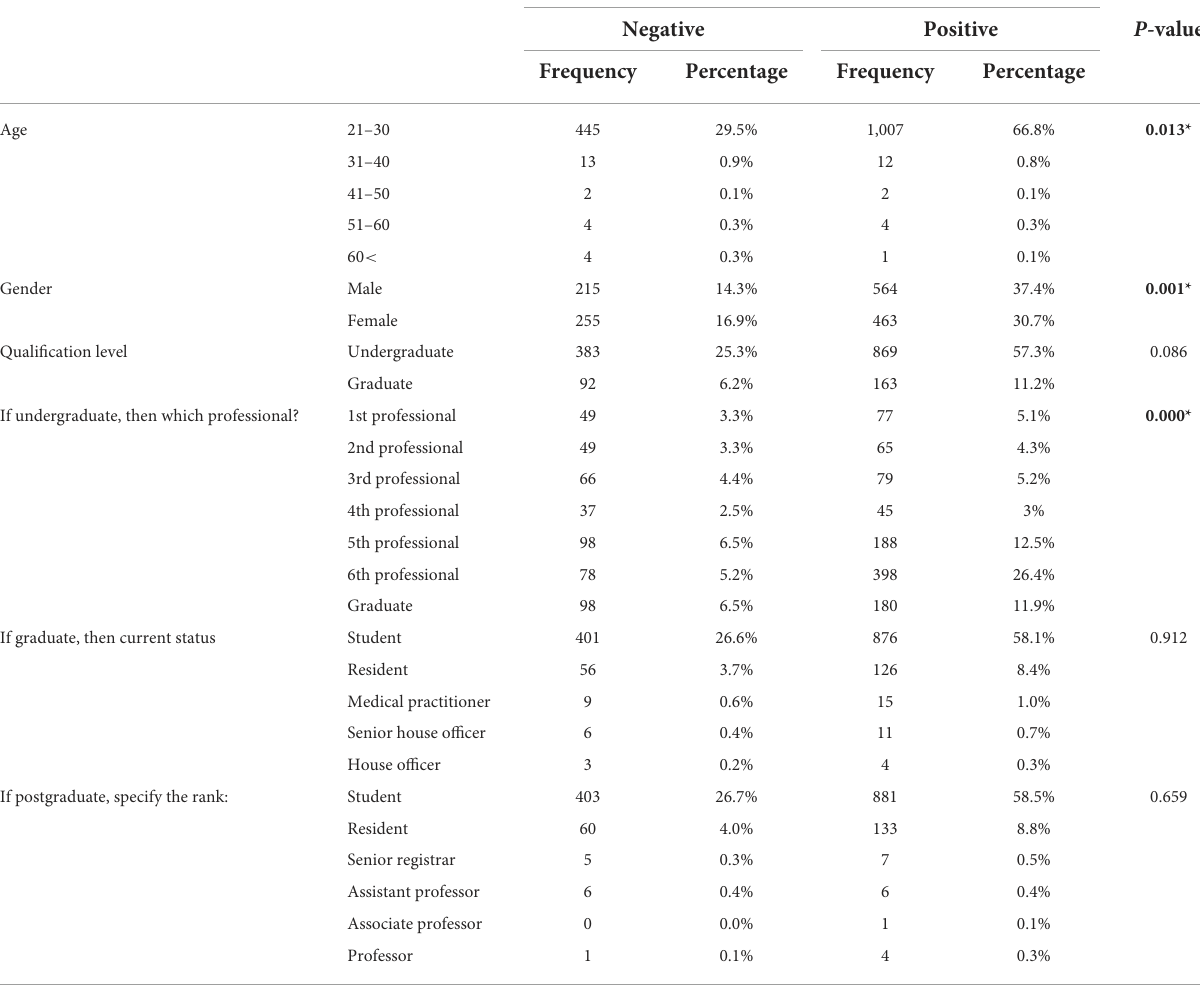
TABLE 7 Attitude toward AI based on gender, age, qualification level, professional, current status and rank of the